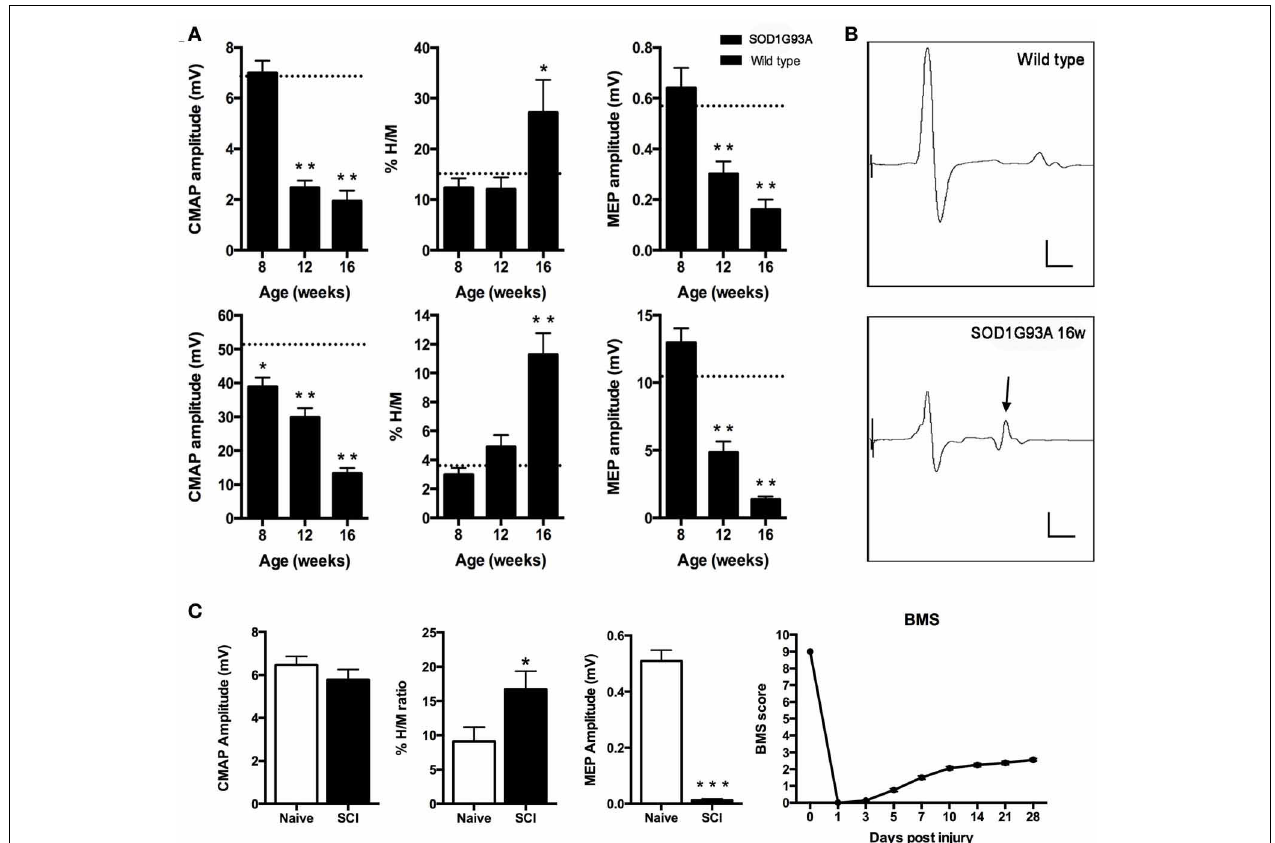
FIGURE 1 | (A,B) Peripheral and central motor conduction along disease progression in SOD1 G93A mice. (A) Plantar (upper) and tibialis anterior (lower) compound muscle action potential (CMAP) amplitude, %H/M ratio and motor evoked potentials (MEP) amplitudes of SOD1 G93A animals at 8, 12, and 16 weeks of age. Values are represented as mean ± s.e.m. Dashed line represents wild type mean value for each parameter. ∗ p < 0 . 05; ∗∗ p < 0 . 01 vs. wild type littermates. (B) Representative recordings of plantar muscle CMAPs. Note the relative increase of the H wave (arrow) reflecting hyperreflexia. Scale bars: 2mV; 2ms. (C)